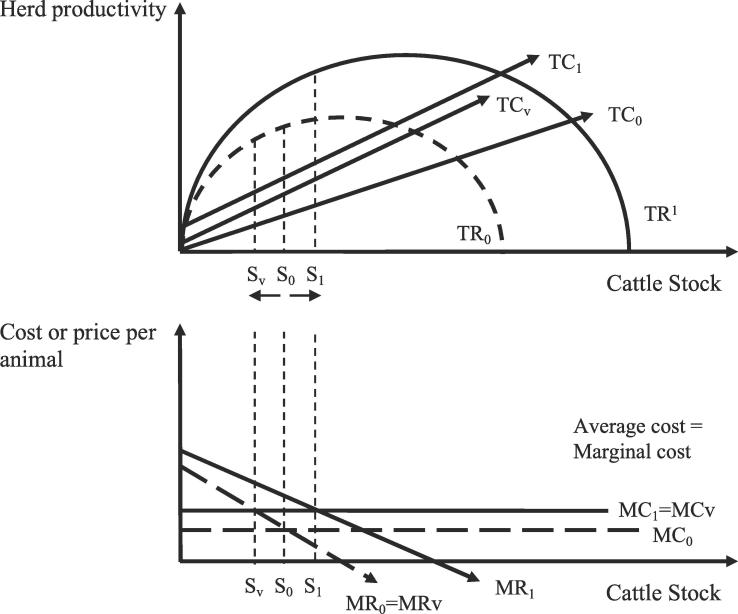
An illustration of the vaccination decision and diagnostic testing decision for this paper. Diagnostic testing adds a fixed cost to the total cost of vaccination (TCv to TC1) while increasing total revenue (TR0 to TR1) for an increase in potential herd profits.